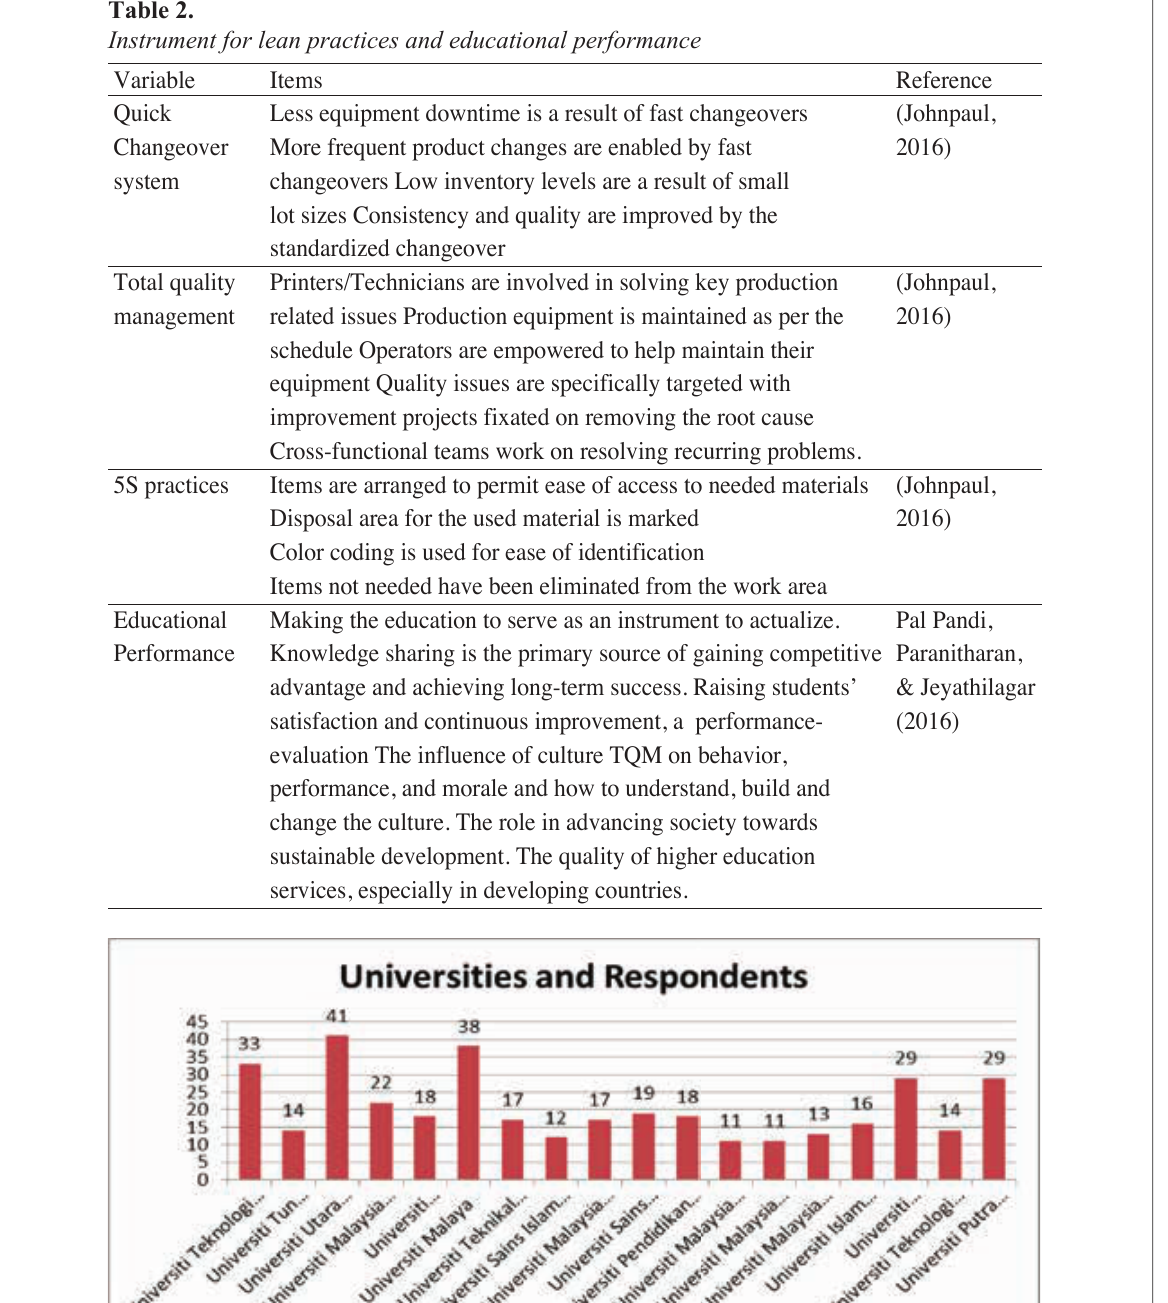
Table 2. Instrument for lean practices and educational